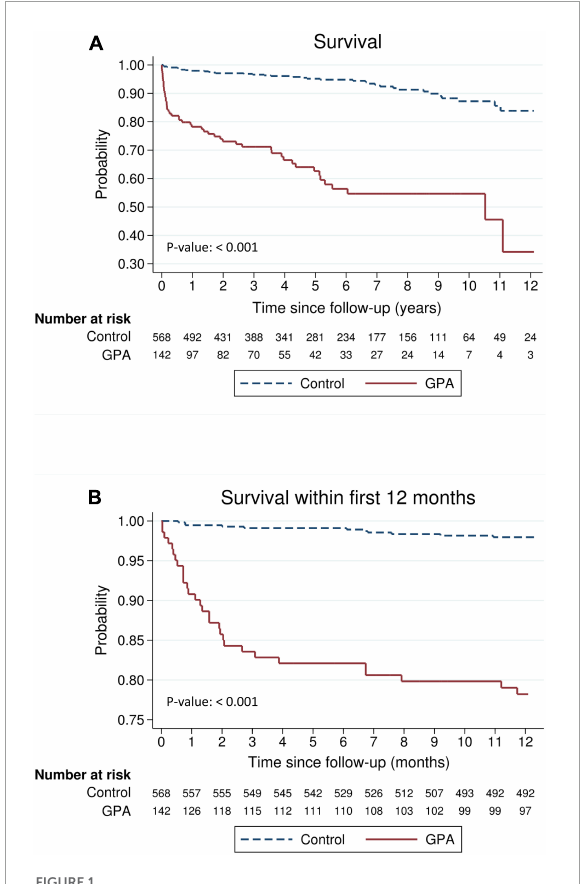
FIGURE1 Survival of patients with granulomatosis with polyangiitis (GPA) compared with an age-, sex-, entry time- and comorbidity-matched general population (A) during the entire follow-up period or (B) within the first 12 months.